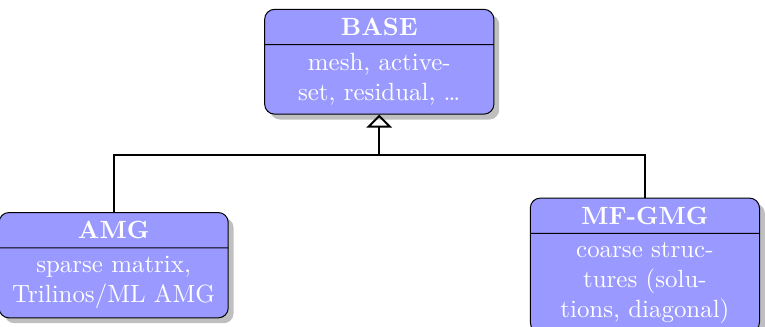
Figure 7. Shared code base for the algebraic multigrid (AMG) and matrix-free geometric multigrid (MF-GMG) implementation.